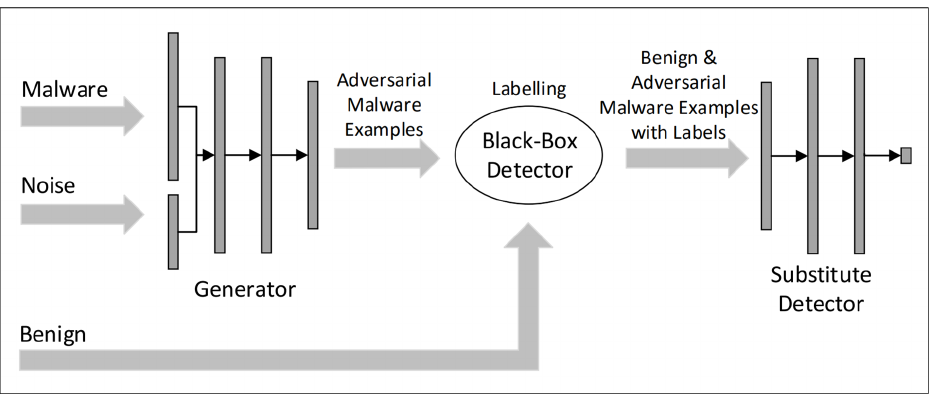
Figure 9. The architecture of MalGAN (Image Credit: Hu et al.